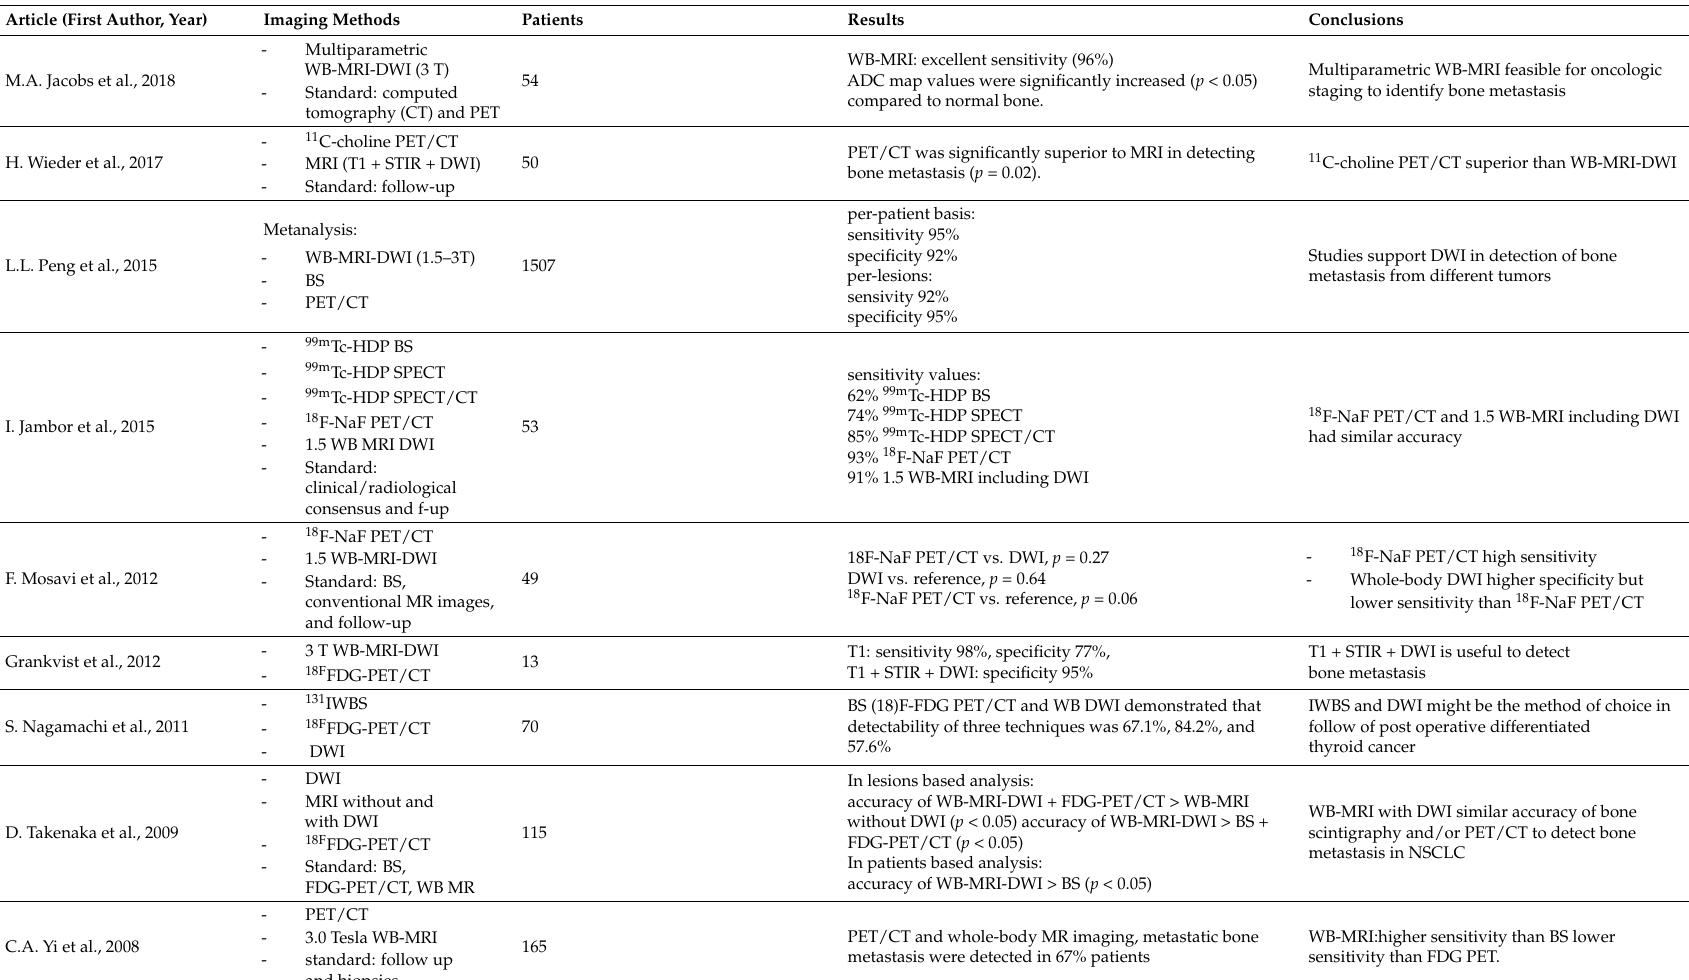
Table 1. Summary of some articles about nuclear medicine and WB-MRI-DWI cited in the